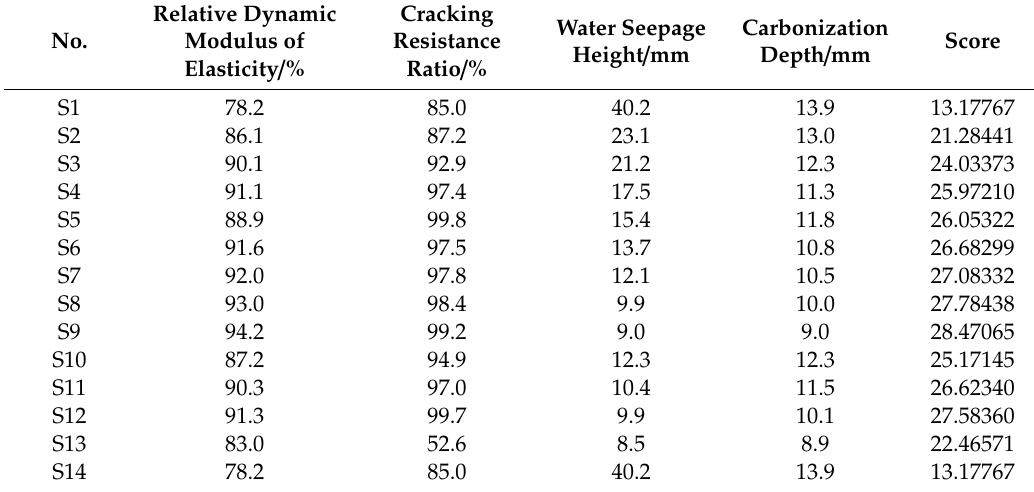
Table 4. Mix proportions of polyvinyl alcohol (PVA) fiber cementitious composites.